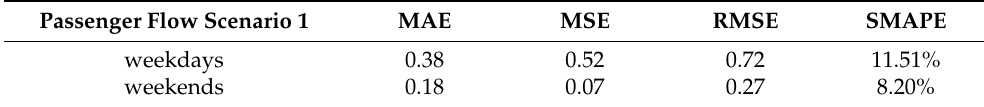
Table 9. The metrics of forecasting results for OD 1.